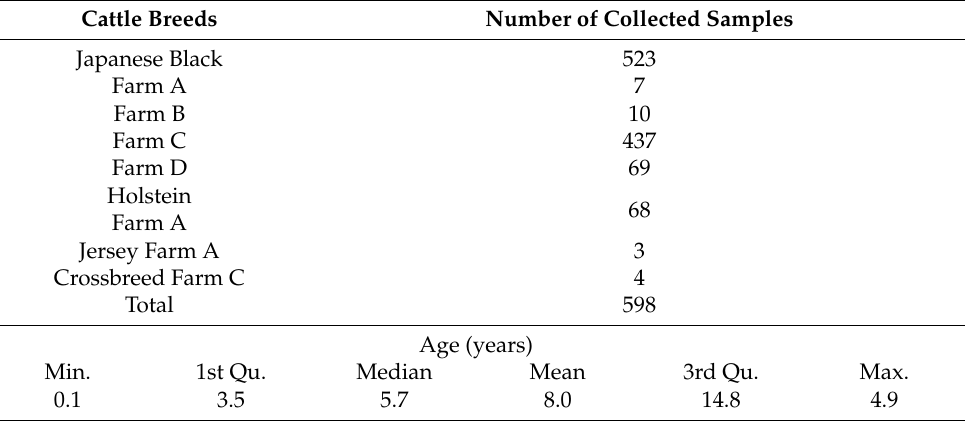
Table 1. Summary of the collected samples and their related statistics for age and proviral load (PVL) in the bovine leukemia virus (BLV)-positive